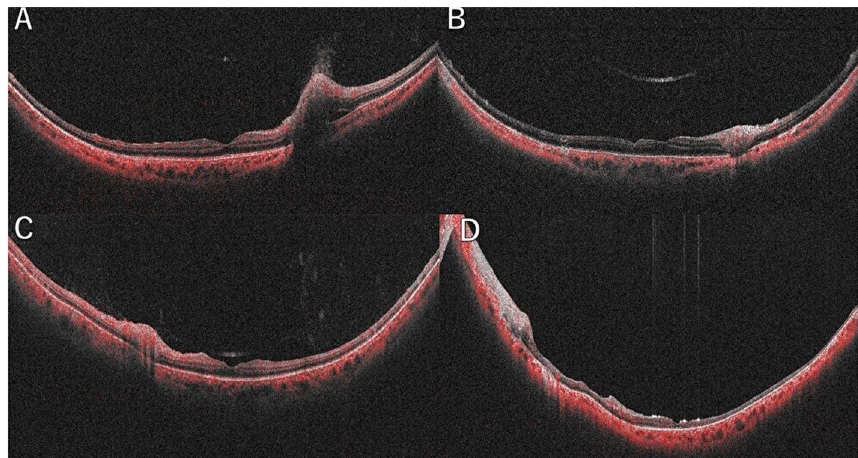
Fig. 4 Optical coherence tomography (OCT) images of the right eye for Case 1. A The first visit, B After the treatment and the leftt eye for Case 2.